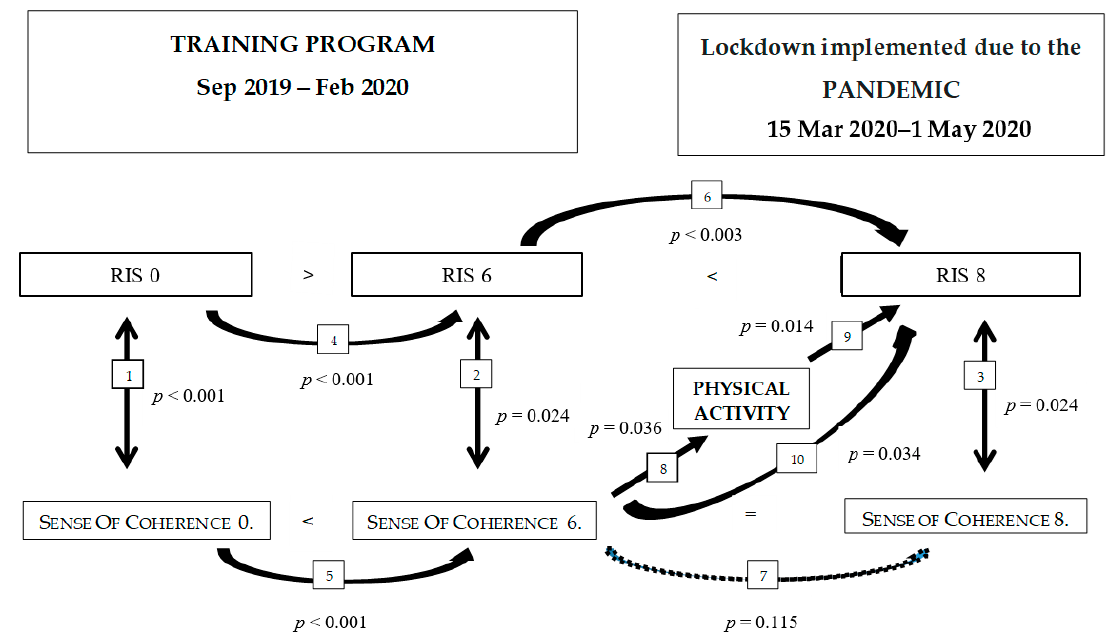
Figure 3. Physical activity and the effect of the sense of coherence before the training program and during the lockdown implemented due to the COVID-19 pandemic. RIS = Regensburger insomnia scale. The number displayed after the variable names is the surveys’ ordinal number: 0 = upon starting the training program, 6 = at the end of the training program (after the six months were completed), 8 = survey after the lockdown.